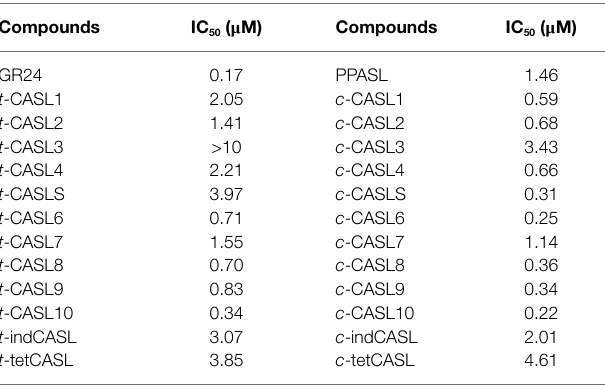
TABLE 1 | Evaluation of me direct interaction between ShHTL7 and CASLs.